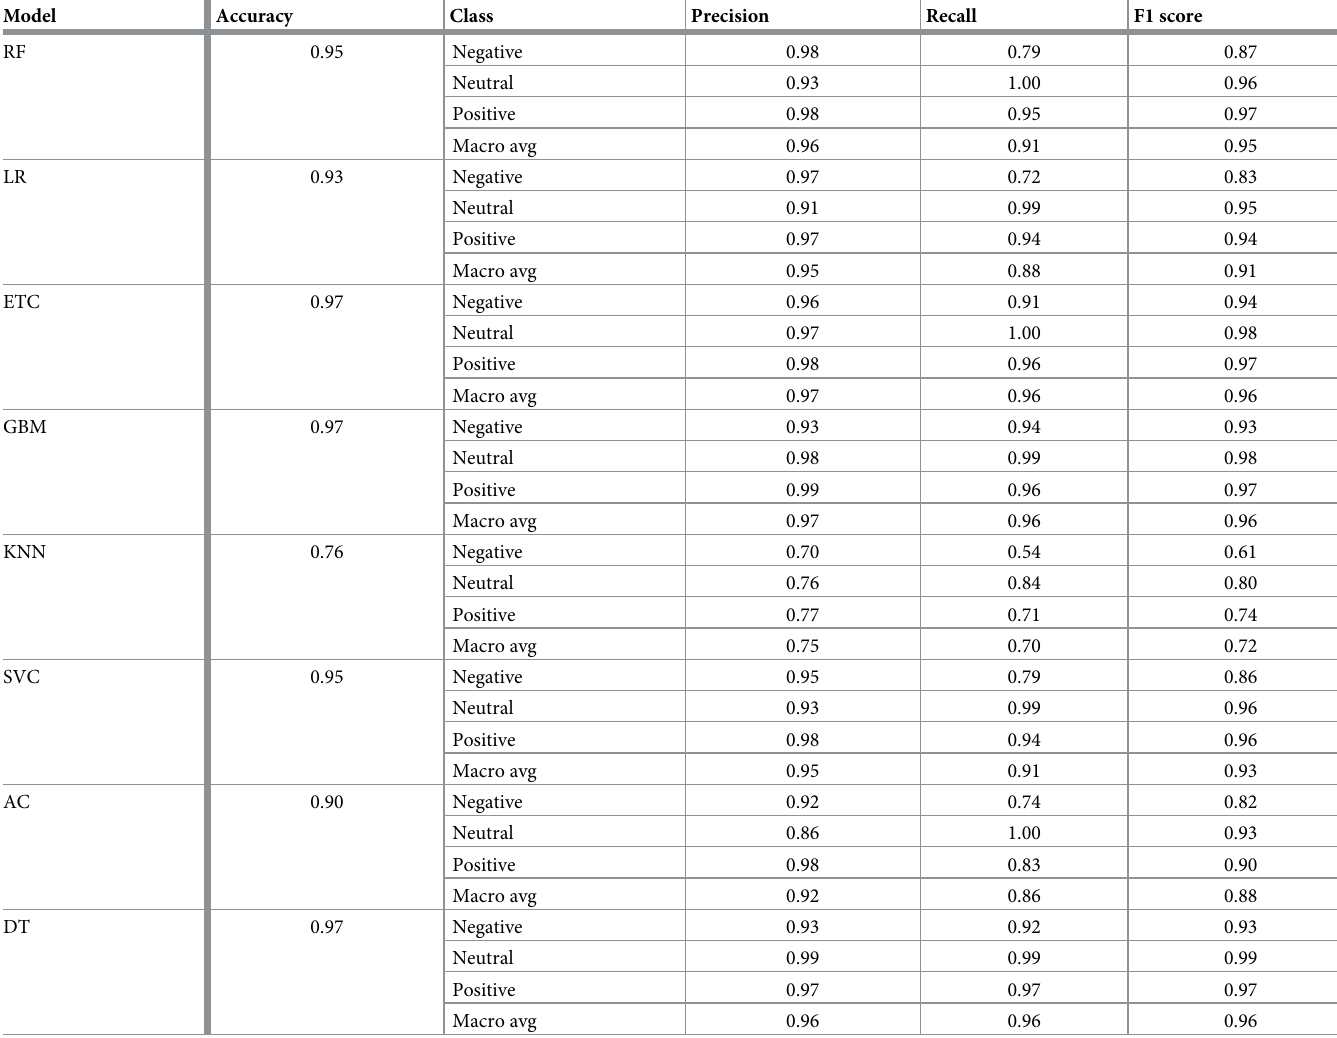
Table 4. Experimental results of machine learning sentiment classifiers using TF-IDF features. Model